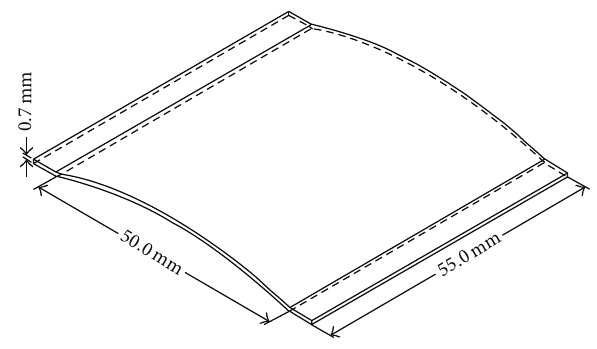
Figure 1: A shallow, thin-walled part [5–7].